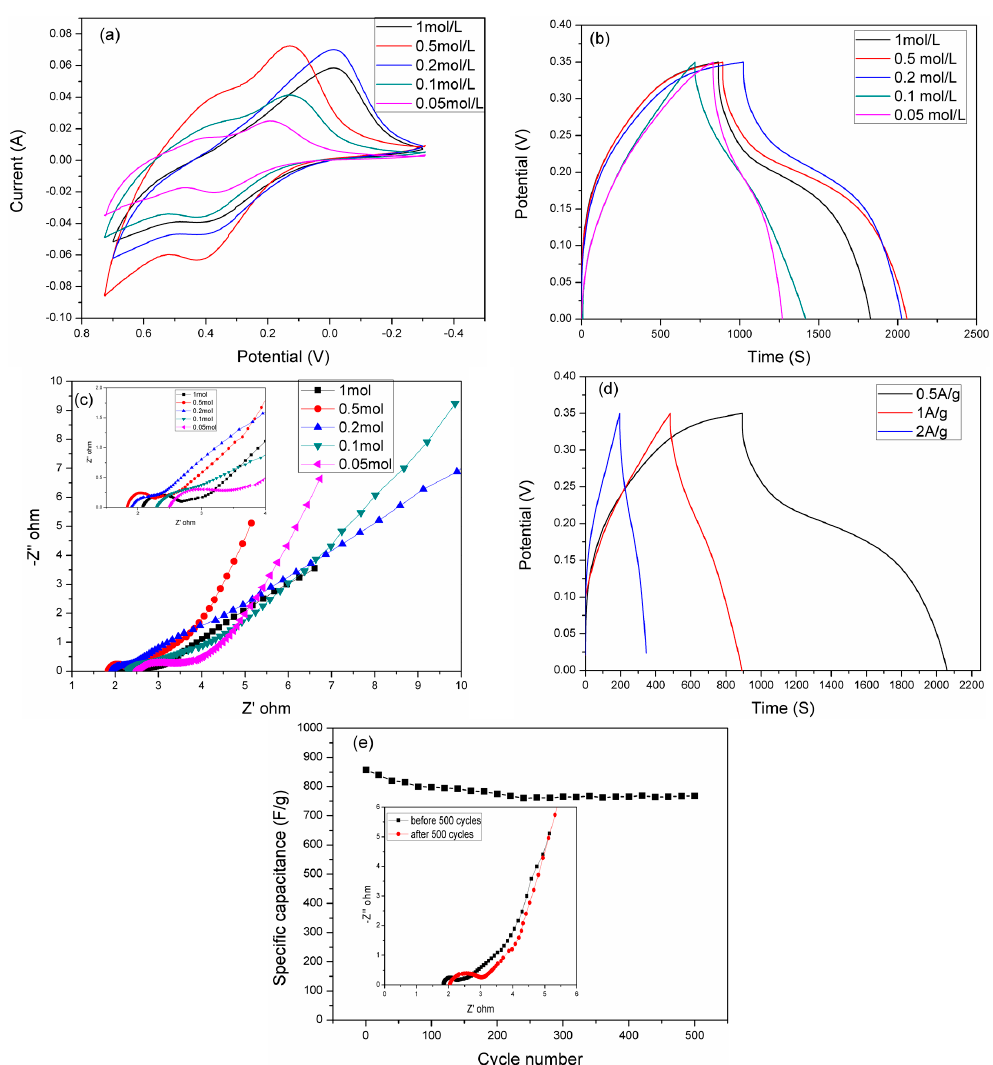
Figure 8. ( a ) CV curves of PANI/MnO 2 in different concentrations of KI with 1 M H 2 SO 4 electrolytes; ( b ) galvanostatic charge–discharge curve of PANI/MnO 2 in different concentrations of KI with 1 M H 2 SO 4 electrolytes; ( c ) AC impedance curve of PANI/MnO 2 in different concentrations of KI with 1 M H 2 SO 4 electrolytes; ( d ) galvanostatic charge–discharge curve of PANI/MnO 2 at different current density in 0.5 M KI–1 M H 2 SO 4 electrolytes; ( e ) Cycling stability of PANI/MnO 2 using galvanostatic charge discharge measurements at a 2 A/g in 0.5 M KI–1 M H 2 SO 4 electrolytes. The inset shows the Nyquist plot of PANI/MnO 2 electrodes before and after cycling stability test.